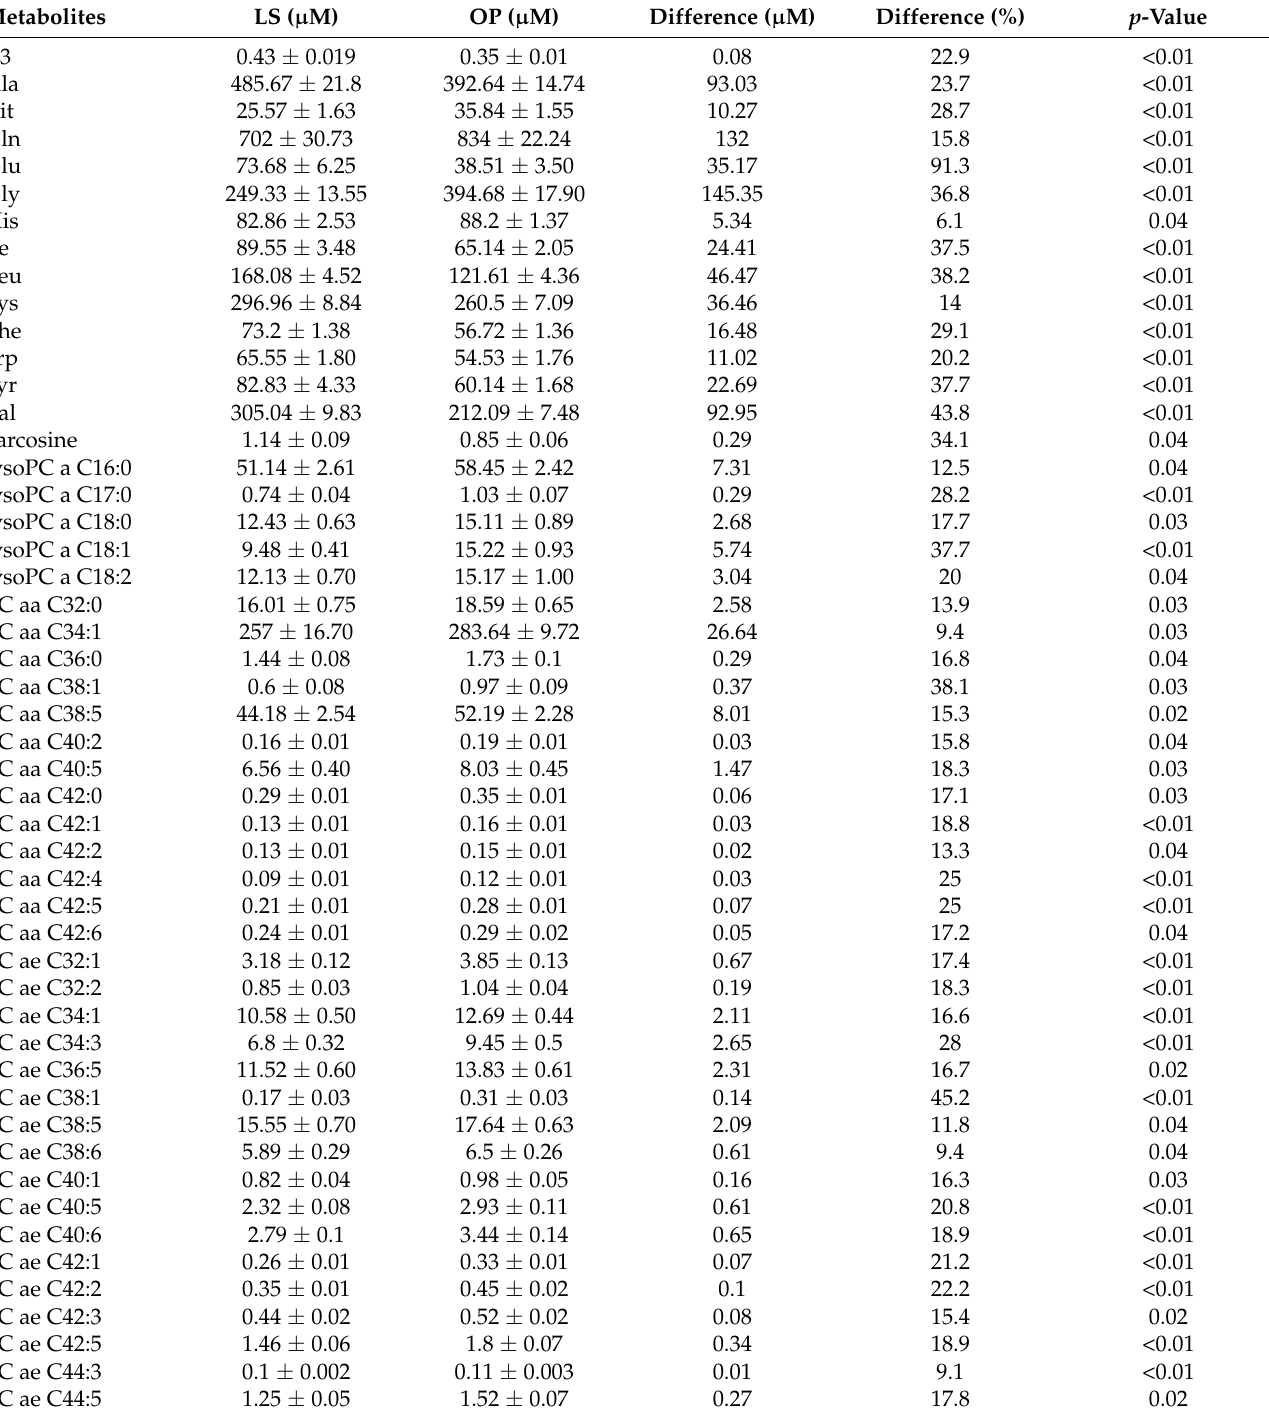
Table 2. One-year follow-up means of 57 significantly different metabolites between LS and OP with standard deviation. p -values are adjusted for sex and age and corrected for multiple comparisons. C, acylcarnitine; lysoPC, lysophosphatidylcholine; PC aa, phosphatidylcholine with ester bonding; PC ae phosphatidylcholine with ether bonding; SM,